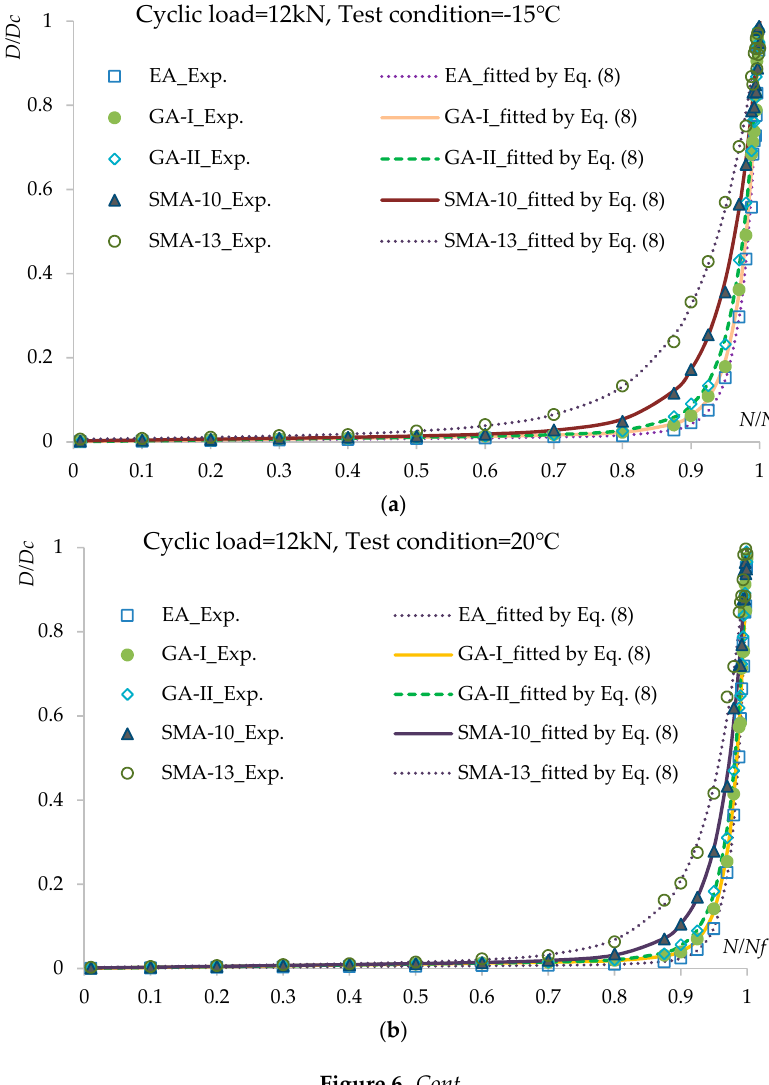
D D D f and i C